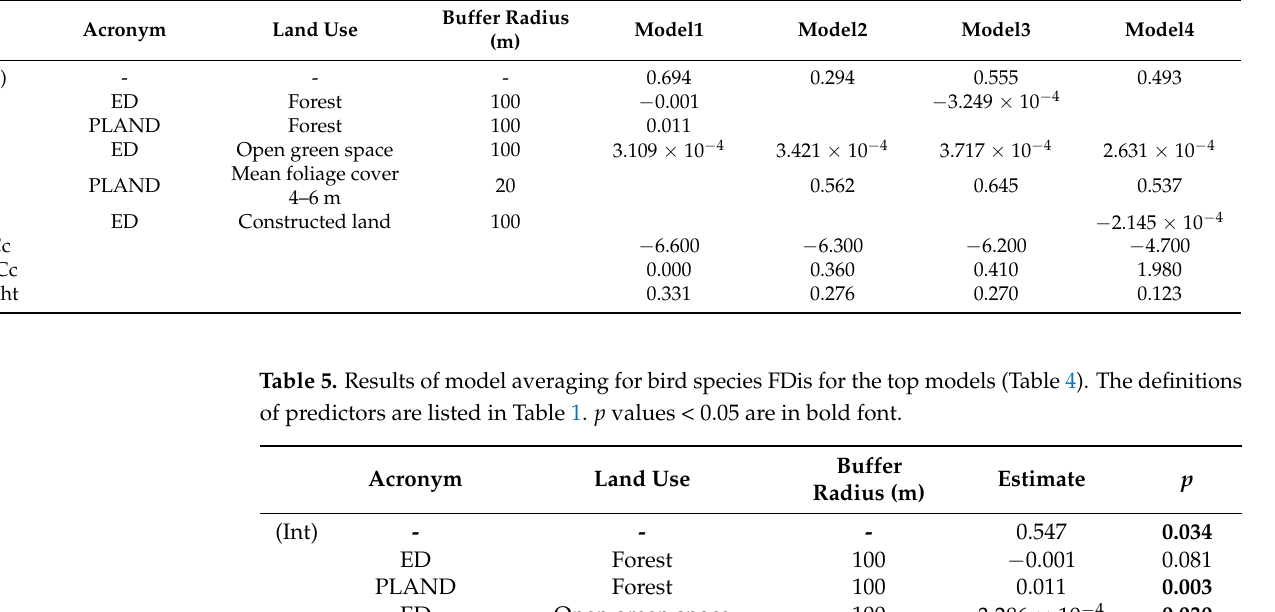
Table 4. The top model set connected landscape- and patch-level variables and bird species FDis, with ∆ AICc < 2 and the number of predictors ≤ 3.